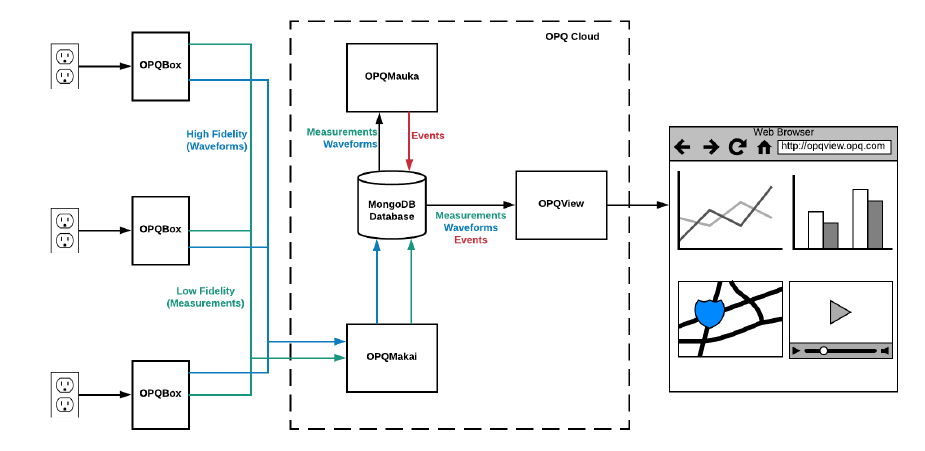
Figure 1. High level system architecture of an Open Power Quality (OPQ) Sensor